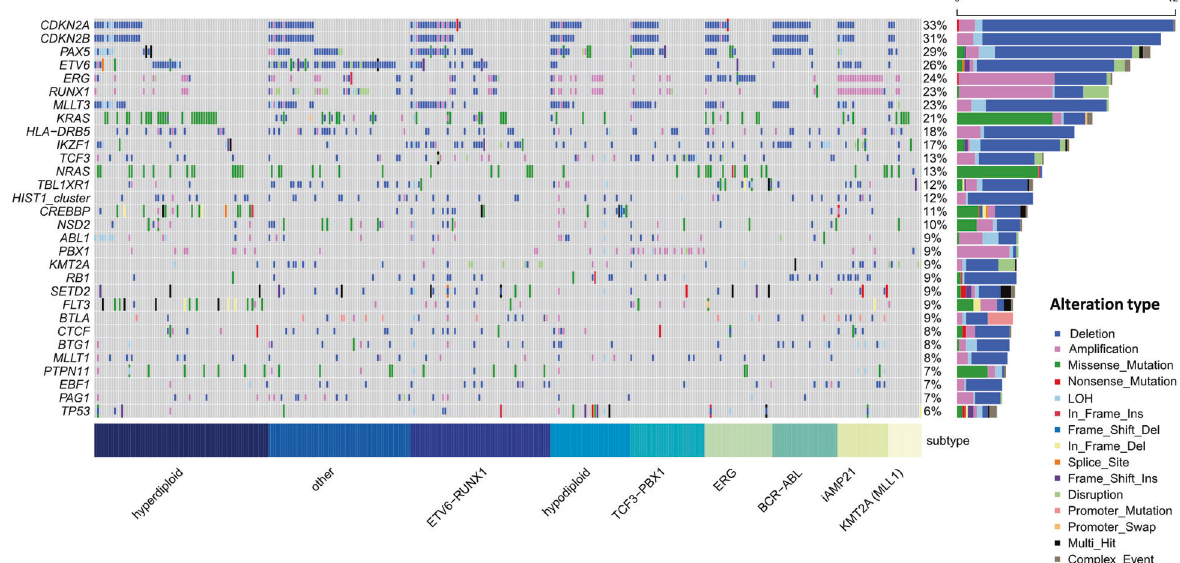
Fig. 2 Driver gene analysis. Oncoplot of somatic alterations for selected ALL driver genes (Supplementary Table 10), genes altered in > 20 tumours, compiled from SNV, indel, CNV (only focal events), SV, RNAseq, and LOH. Vertical lines represent one tumour. Coloured sections in grey grid denote alteration type, described in key - “ Alteration type ” . Short nucleotide variants span the entire row, other alterations span half the row width. The right bar plot shows the frequency of driver gene alteration, colour denotes alteration type, as prior. Deletions and ampli fi cations derived from CNVs and SVs; disruption from RNAseq and SVs. Alterations are shown non-redundantly; tumours with multiple alterations in the same gene only counted once. Plot generated using Maftools [6] after the exclusion of genes in the psuedoautosomal